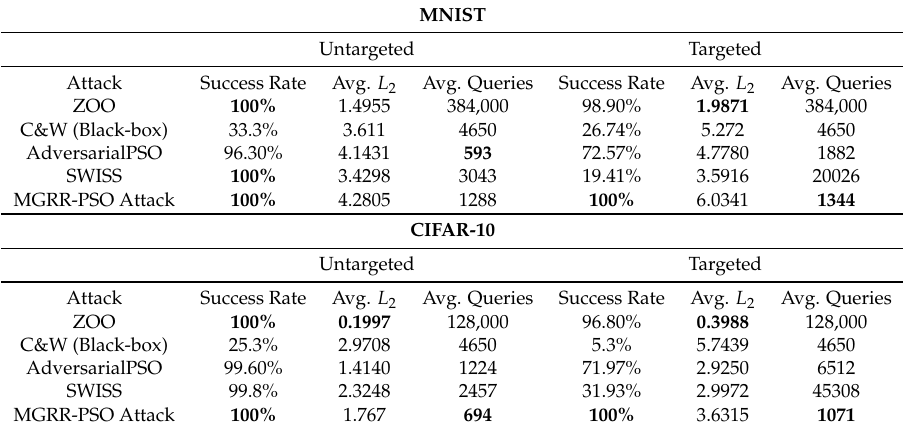
Table 1. Attack performance comparison using C&W model on MNIST and CIFAR-10